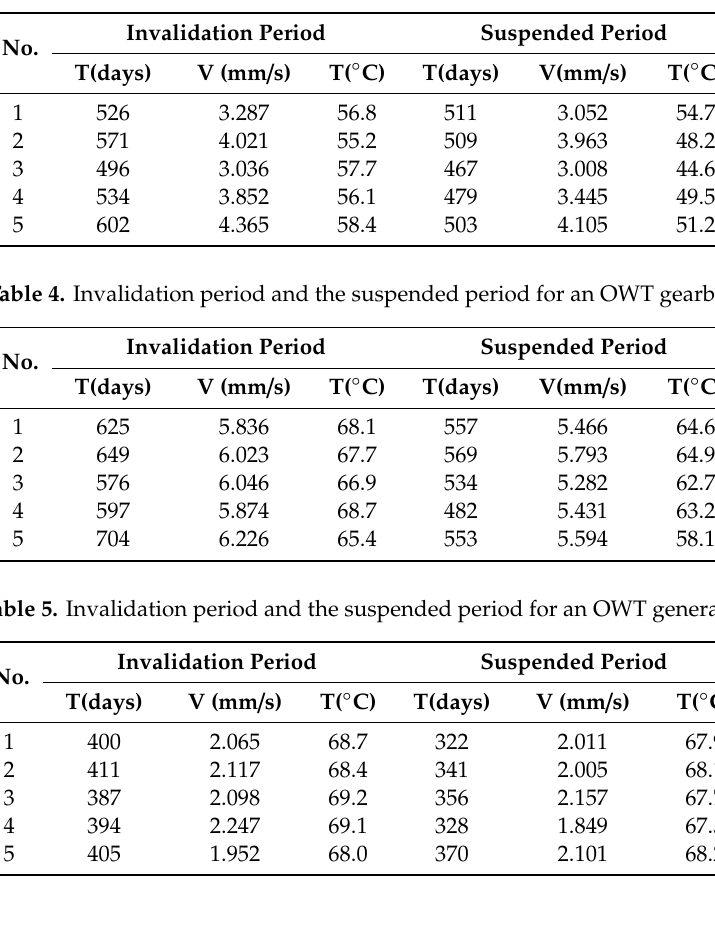
Table 3. Invalidation period and the suspended period for an OWT rotor.